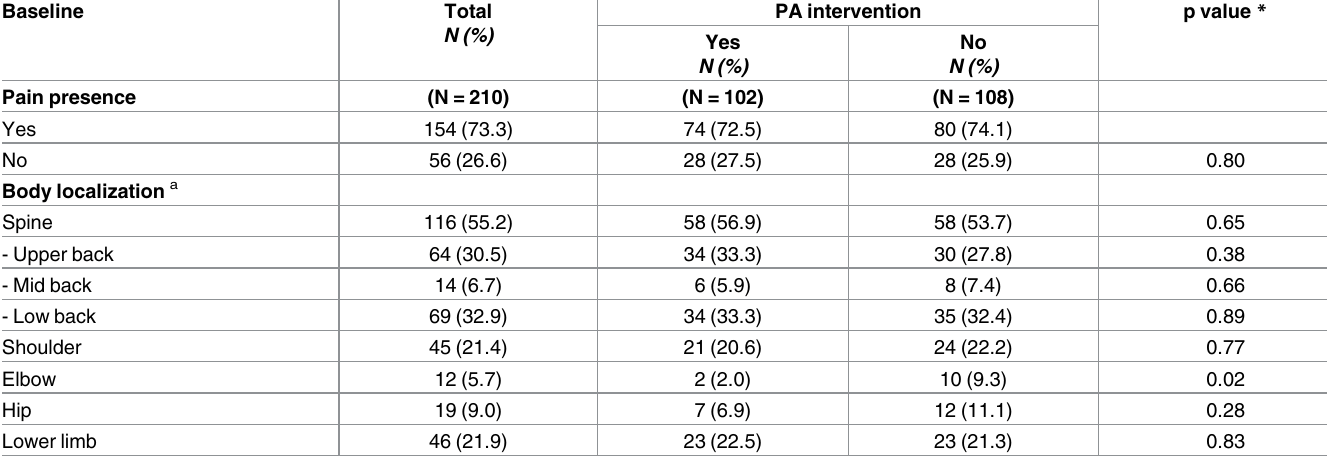
Table 2. Prevalence and body localization of pain reported by study women at baseline, overall and according to physical activity (PA)